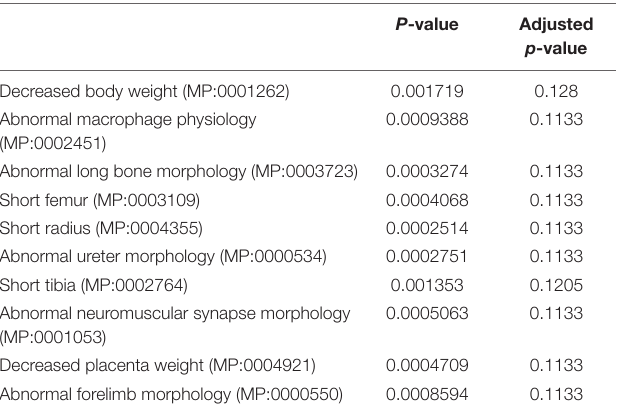
TABLE 1 | MGI mammalian phenotypic identification of undifferentiated DEGs between wild-type and Dnmt3l KO MSCs by enrichment analysis.